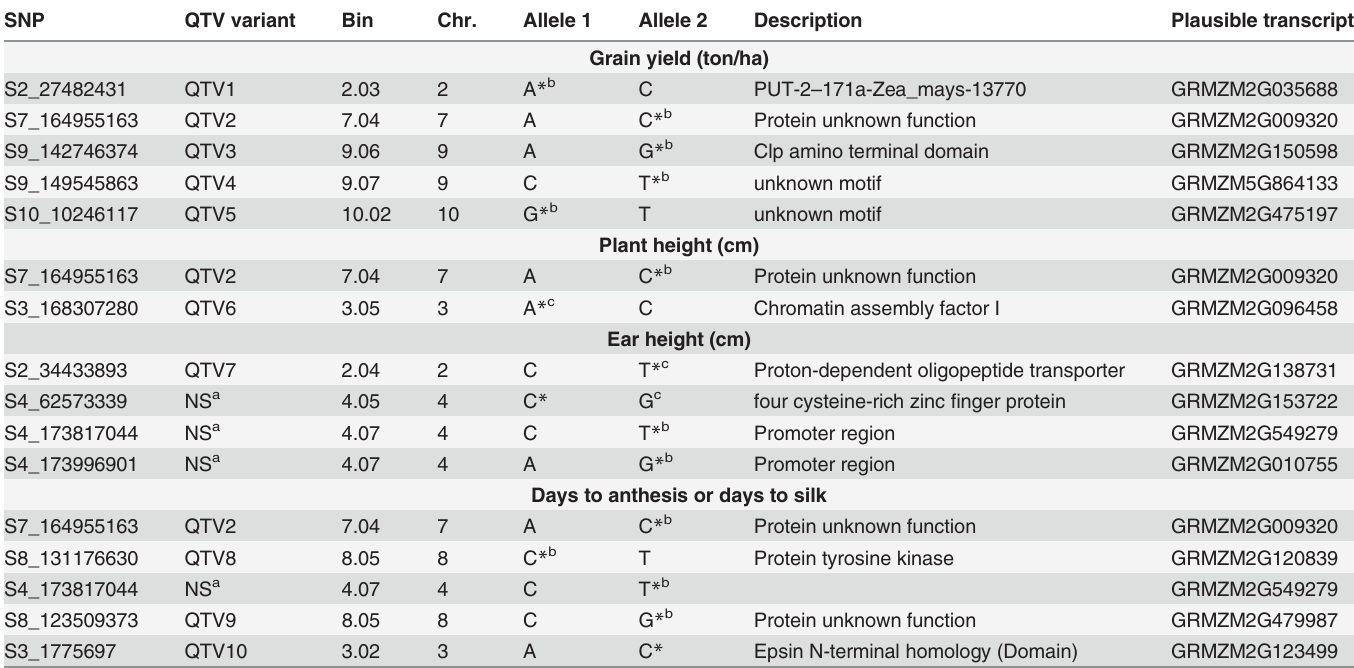
Table 9. Summary of the most promising QTV variants found in this study.